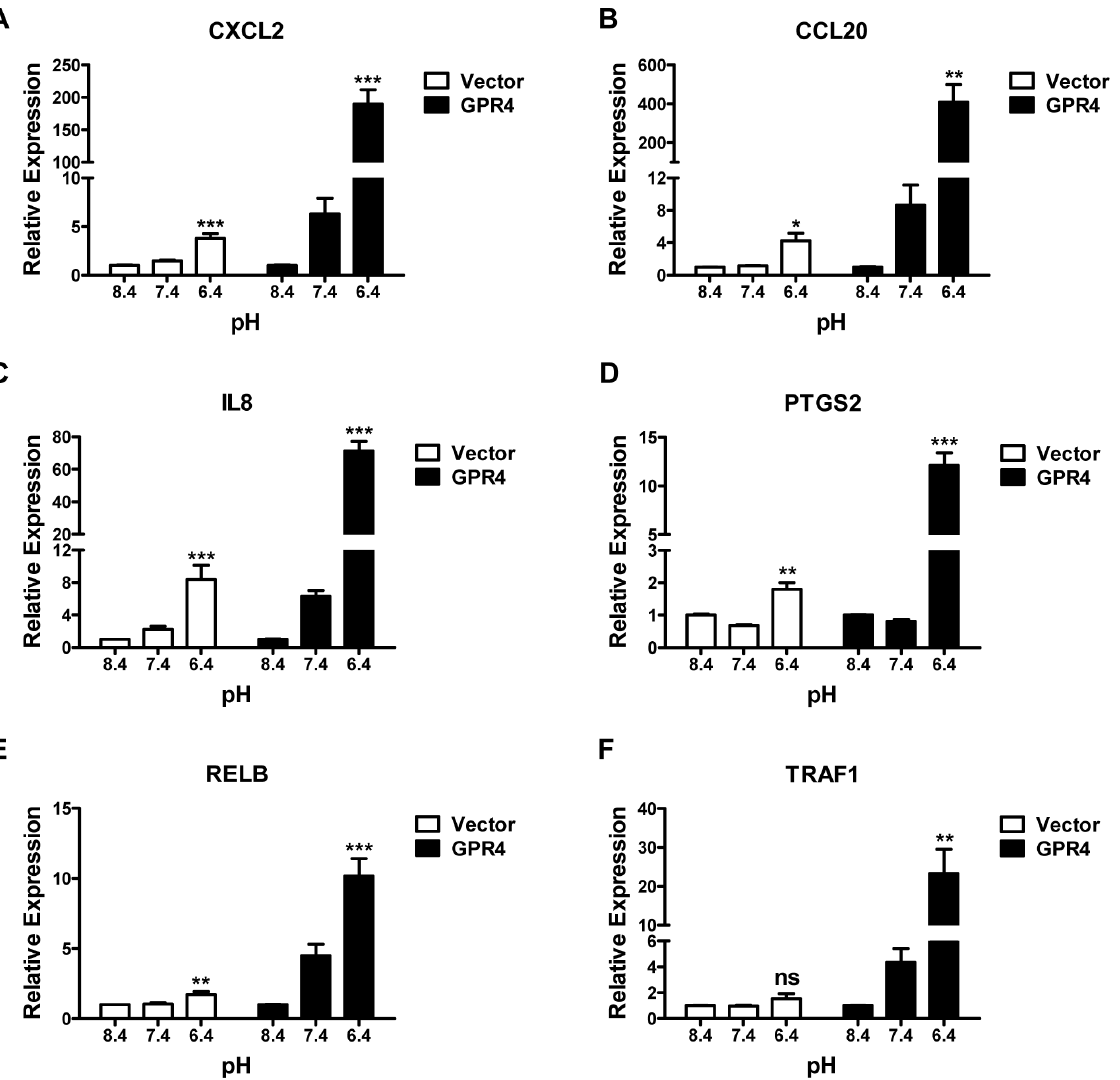
Figure 2. Validation of microarray by real-time RT-PCR. HUVECs transduced with the control vector (Vector, white bars), or the GPR4 expression construct (GPR4, dark bars) were treated with EGM-2/HEM media at pH 8.4, 7.4, or 6.4 for 5 h. Total RNA was isolated and cDNA was synthesized. Real-time RT-PCR quantification of mRNA levels of CXCL2 (A), CCL20 (B), IL8 (C), PTGS2 (D), RELB (E) and TRAF1 (F) was performed. Ct values were normalized to the housekeeping gene GAPDH. The expression level of the target gene in HUVEC/Vector or HUVEC/GPR4 cells at pH 8.4 was set as 1. Error bars indicate the mean 6 SEM. *, P , 0.05; **, P , 0.01; ***, P , 0.001; ns , not significant ( P . 0.05); compared with the pH 8.4 groups. The results shown are the average of at least two biological repeats.